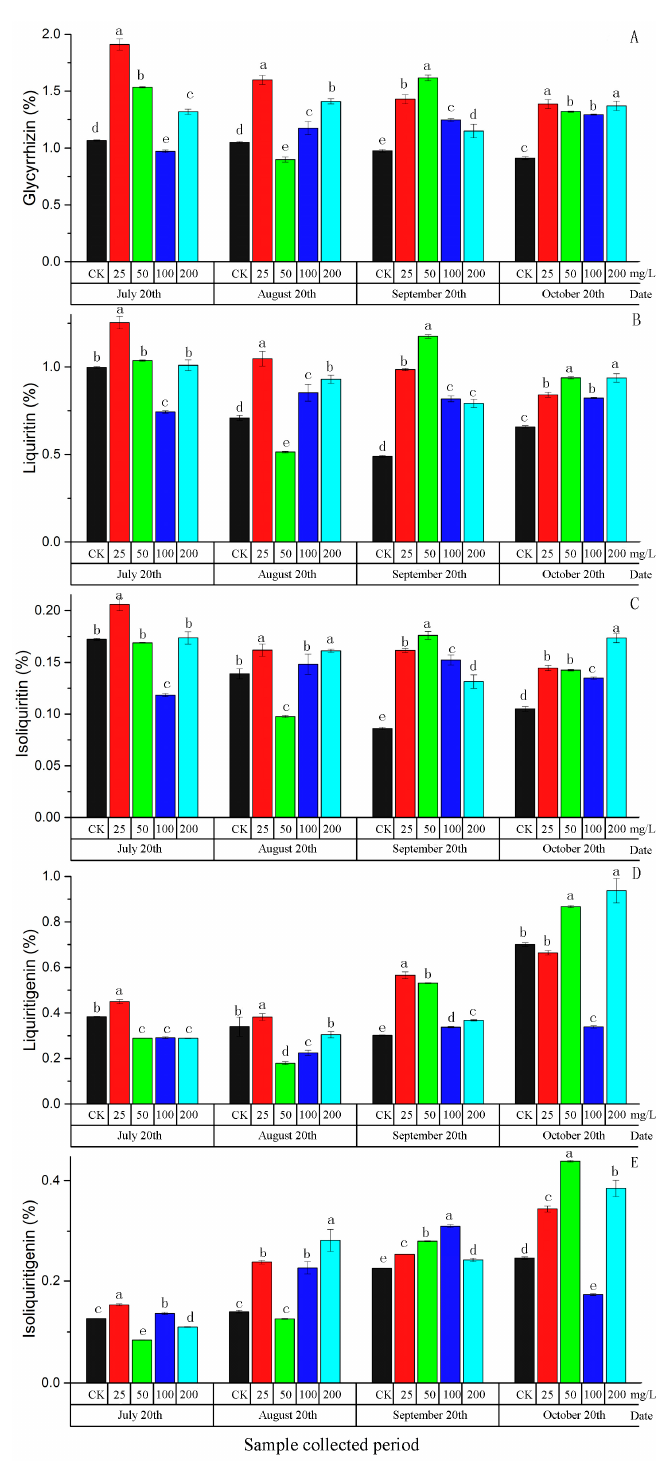
Figure 3. The effect of ABA on five active components in G. uralensis root. ( A ) glycyrrhizin ( I ), ( B ) liquiritin ( II ), ( C ) isoliquiritin ( III ), ( D ) liquiritigenin ( IV ), ( E ) isoliquiritigenin ( V ). Different letters followed by mean ± standard error indicate significant differences at p < 0.05. CK, Control solution contained Tween 20 without ABA.